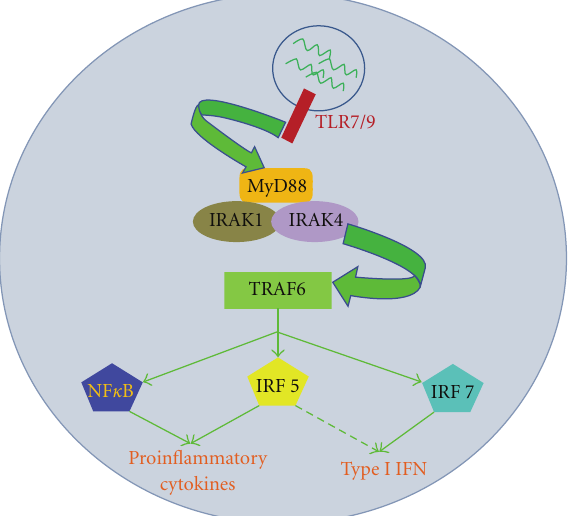
Figure 1: TLR7/9 Signaling pathway leading to the production of proinflammatory cytokines and type I IFN. Receptor recognizes nucleic acid ligand and recruits adaptor protein MyD88. MyD88 attracts kinases IRAK1 and IRAK4 to the complex, which can then activate TRAF6. Activated TRAF6 leads to the stimulation of transcription factors NF κ B, IRF5, and IRF7 to produce cytokines and type I IFN. IRF7 has been identified as the primary factor in production of type I IFN, but there is evidence that IRF5 can also contribute to type I IFN production